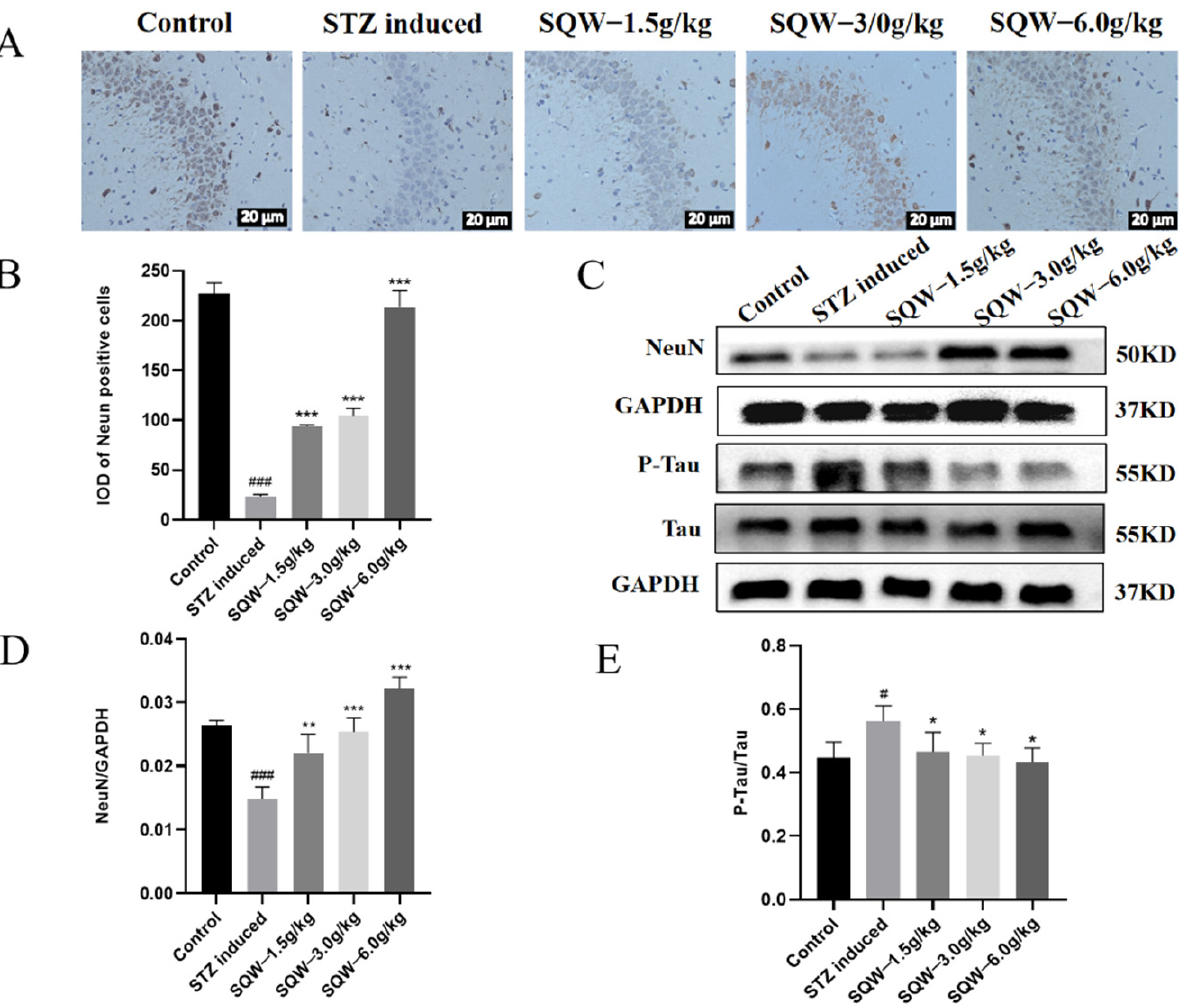
Figure 4. SQW improves NeuN neuron loss and Tau hyperphosphorylation in the hippocampal CA3 region in STZ-induced rats. ( A ) Immunohistochemical staining results of NeuN protein in hippocampal CA3 region. ( B ) Statistical results of IOD of hippocampal NeuN protein integral optical density in hippocampal CA3 region. ( C ) Protein bands for NeuN, Tau, and p-Tau. ( D ) The effect of SQW on NeuN protein expression. ( E ) The Effect of SQW on the phosphorylation level of Tau pro- tein. All of the results are expressed as means ± SD, n = 3 per group. Compared with the control group, # p < 0.05, ### p < 0.001; compared with the STZ induced group, * p < 0.05, ** p < 0.01, *** p < 0.001.